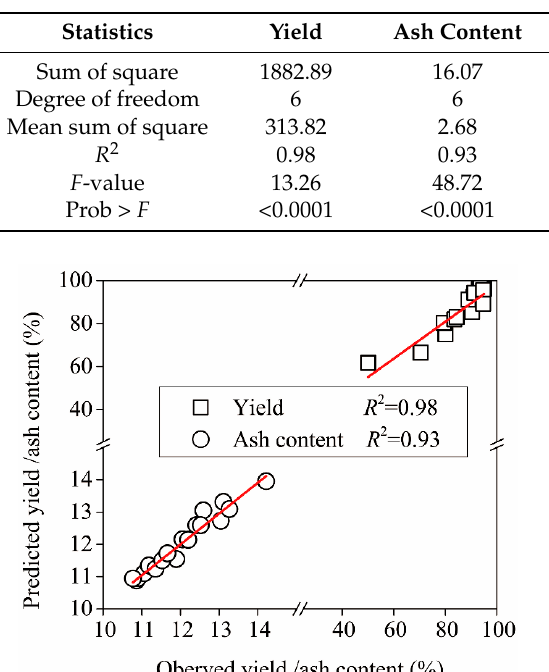
Table A1. Statistical significance of the whole model for yield and ash content of the concentrate.